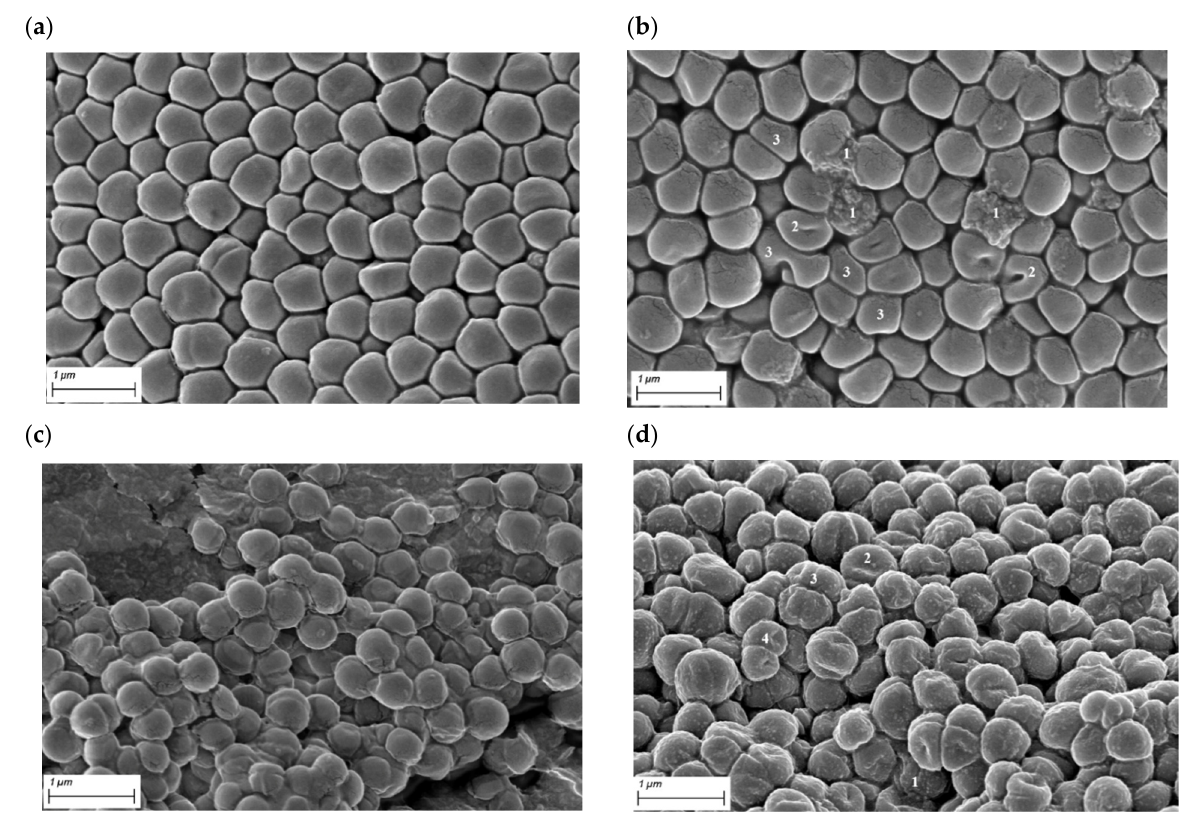
Figure 8. Scanning electron microscopy images: ( a ) MRSA 1 cells unexposed to the RMF; ( b ) MRSA 1 cells exposed to the RMF (5 Hz); ( c ) MRSA 2 cells seeded on an agar plate in the presence of a disc containing cefoxitin; ( d ) MRSA 2 cells seeded on an agar plate in the presence of a disc containing cefoxitin and exposed to the RMF (5 Hz). 1—cellular content leakage; 2—collapse of cell wall; 3—strong deformation of cellular shape, 4—cell size reduction. Scale bars represent 1 µm.